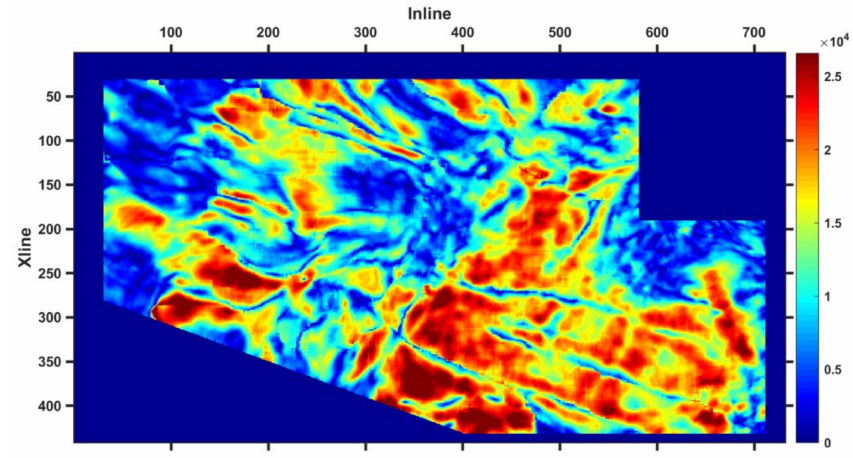
Figure 10. The instantaneous amplitude attribute of the coal seam. 2. Waveform difference. The waveform difference attribute is one of the best seismic attributes for fault characterization, because the seismic wave will scatter when passing through the geological anomalous body, resulting in obvious differences. Therefore, it can obtain clearer imaging results than other traditional attributes. There are faults in the local maximum of the waveform difference and the maximum value increases significantly with the increase of the fault drop. In Figure 11, the warm color band area with maximum value is clearly distributed, showing warm-color band patches like a network and the effect is relatively ideal.